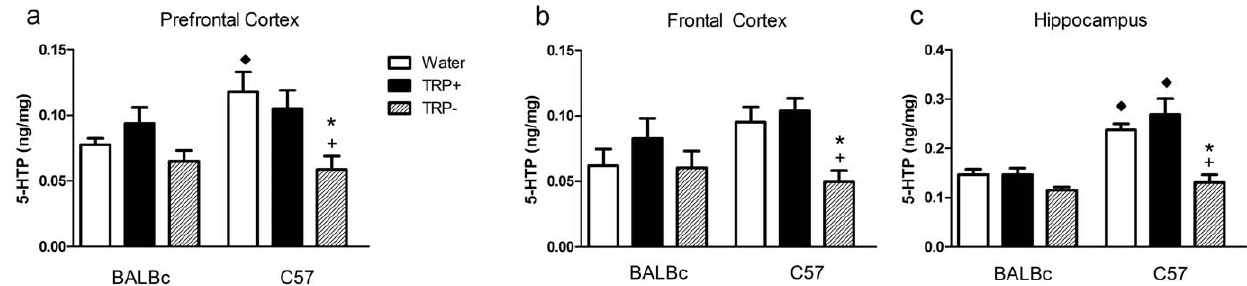
Figure 3. Brain 5-HTP. Brain 5-HTP content in ng/mg tissue in (a) prefrontal cortex (b) frontal cortex and (c) hippocampus. Animals were treated as described in Figure 2. Only NSD 1015-treated animals are shown. N=6/group. * different from Water, + different from TRP + , ¤ different from corresponding group in BALBc mice. TRP 2 decreased 5-HT synthesis in all brain regions, but the results were only statistically relevant in C57 mice; TRP + did not increase 5-HT synthesis; at baseline, BALBc mice had a lower level of 5-HT synthesis in the hippocampus and the prefrontal cortex, but not in the frontal cortex.